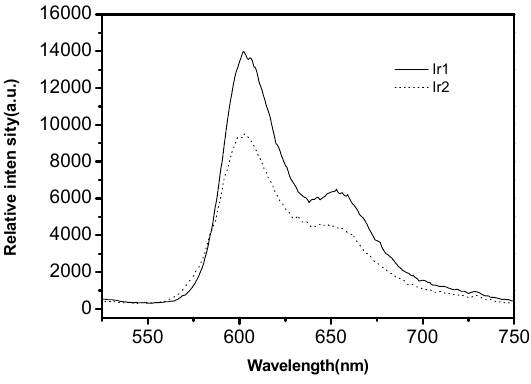
Figure 7. Acetonitrile coordination compoundes of Ir1 and Ir2 (2 × 10 − 5 mol/L) phosphorescence emission spectra.